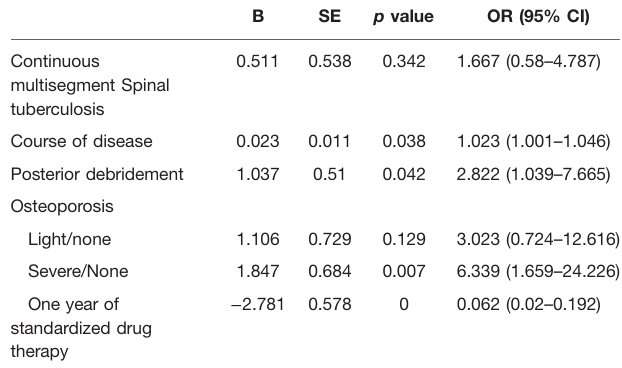
TABLE 4 | Logistic multivariate regression analysis of related risk